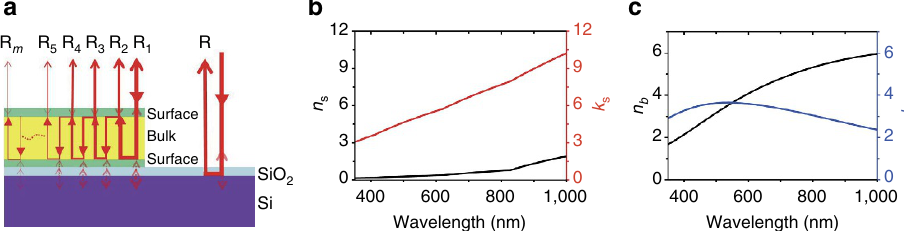
Figure 2 | Physical mechanism of the Sb 2 Te 3 thin film cavity. ( a ) Diagram of internal light multiple reflections in the resonant cavity of the Sb 2 Te 3 thin film. The semi-transparent arrows indicate interface reflections. ( b ) The surface refractive index n and extinction coefficient k curves of the Sb 2 Te 3 thin film as a function of wavelengths. ( c ) The bulk refractive index n and extinction coefficient k curves of the Sb 2 Te 3 thin film as a function of wavelengths.